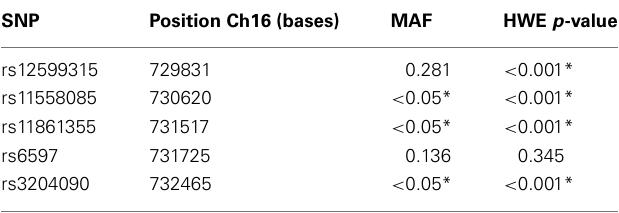
Table 2 | SNPs from CHIP gene evaluated in this cohort.